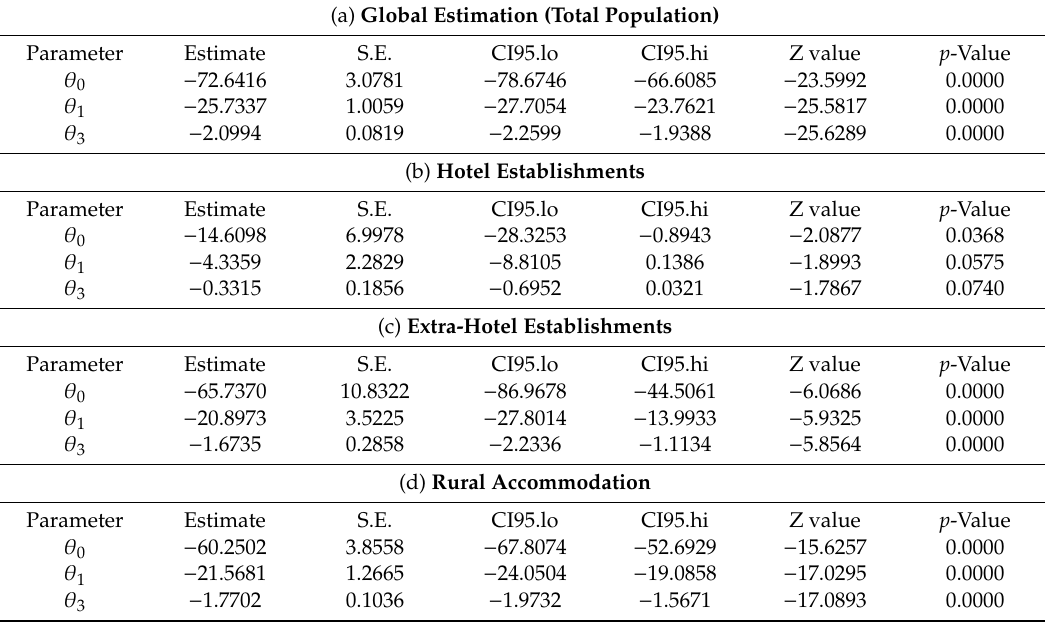
Table 6. Estimation of model (5) λ ( u ,x ) = exp ( θ 0 + θ 1 x + θ 3 x 2 ) . (a) Global Estimation (Total Population)